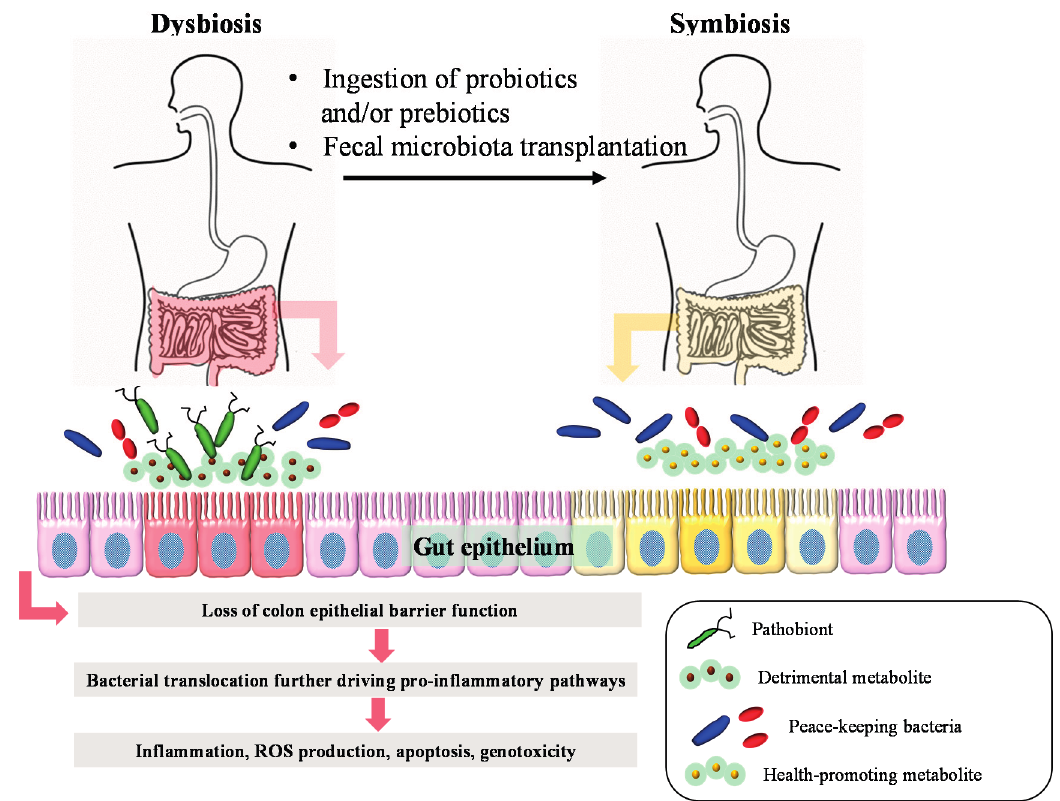
Figure 2. Dysbiosis-related inflammatory bowel diseases and colorectal cancer and relevant therapeutic interventions. Dysbiosis refers to the imbalance between the peace-keeping bacteria and the pathobionts, leading to intestinal diseases such as inflammatory bowel disease and colorectal cancer. Some bacterial metabolites can cause direct DNA damage or promote inflammation. Pathobionts also exert pro-inflammatory effects. In addition, the loss of barrier function will result in increased bacterial translocation, further driving pro-inflammatory pathways, resulting in tumorigenesis. Ingestion of probiotics and/or prebiotics and fecal microbiota transplantation have been reported to restore